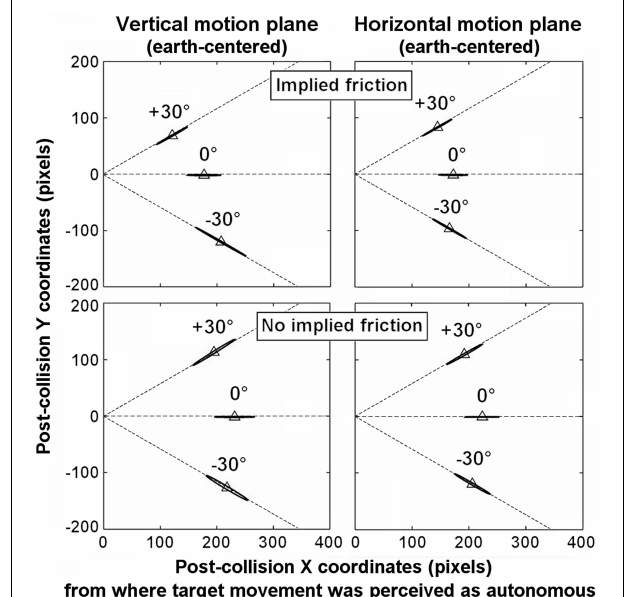
FIGURE 2 | Illustration of the 95% confidence interval ellipses around the mean position where participants felt the target movement started to be autonomous among each Implied friction group, for each condition of the Motion slope × Motion plane interaction. The 0,0 coordinate in the left-hand y-axis on each panel reflects the initial location of the target (i.e., its location at the time it is contacted by the launcher). The dashed lines (not visible in the stimulus) illustrate the direction traveled by the